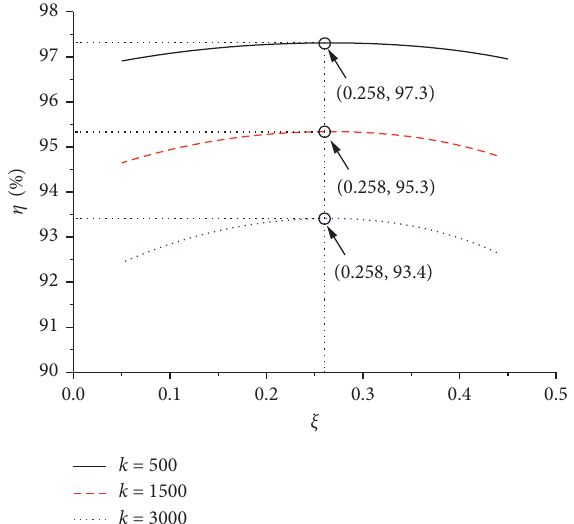
Figure 13: Vibration isolation rate curve of isolation device with damping